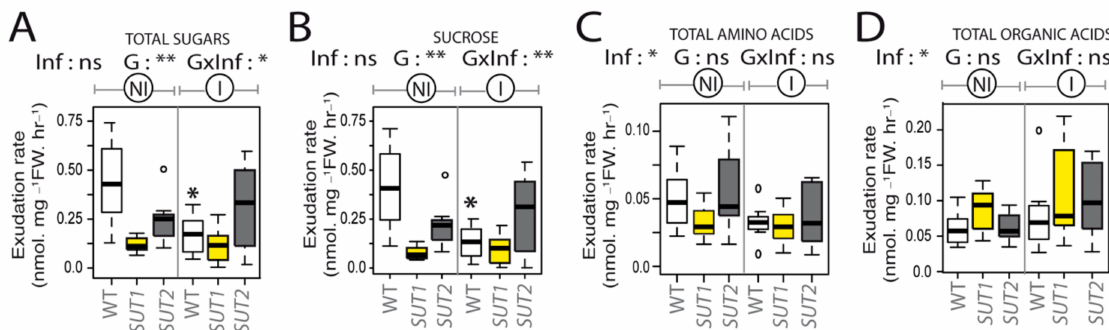
Figure 6. Rate of phloem exudation of metabolites from L3 leaves in response to the infection. Exudation rate is expressed in nmol mg − 1 fresh weight (FW) per hour of exudation. Boxplots show rates of total sugars ( A ), sucrose ( B ), total amino acids ( C ) and total organic acids ( D ) in noninfected (NI) and infected plants (I). The probabilities obtained by a two-way ANOVA, indicating the effects of the Infection (Inf), the Genotype (G) and interaction of Genotype by Infection (GxI), are shown on each boxplot header. The box and whisker plots show the distribution of the biological replicates. Inside black lines represent medians, top and bottom ends of the boxes represent the first and the third quartiles, respectively, and whisker extremities (open circles) represent the maximum and minimum data points when different from the first and third quartiles ( n = 6–8). Asterisks above whisker plots indicate significant differences by a t -test in infected compared to the noninfected plants of the same genotype. p -values: * p < 0.05 and ** p < 0.01; ns, not